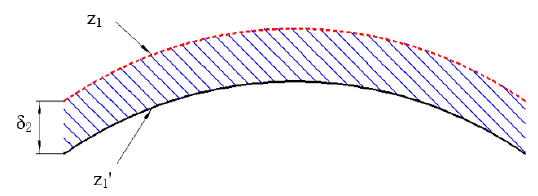
Figure 4. Cutting error.